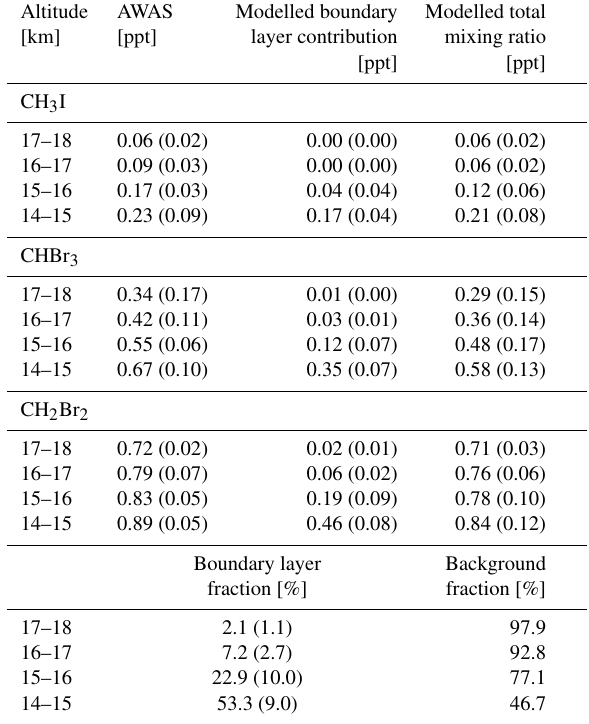
Table 2. ATTREX 2014 research flight 02. AWAS observations; modelled boundary layer contribution; and the modelled total mix- ing ratios for CH 3 I, CHBr 3 , and CH 2 Br 2 . The boundary layer and background fraction means and standard deviations (in brackets) are given based on the measurements and modelled values for the sam- ples collected during the